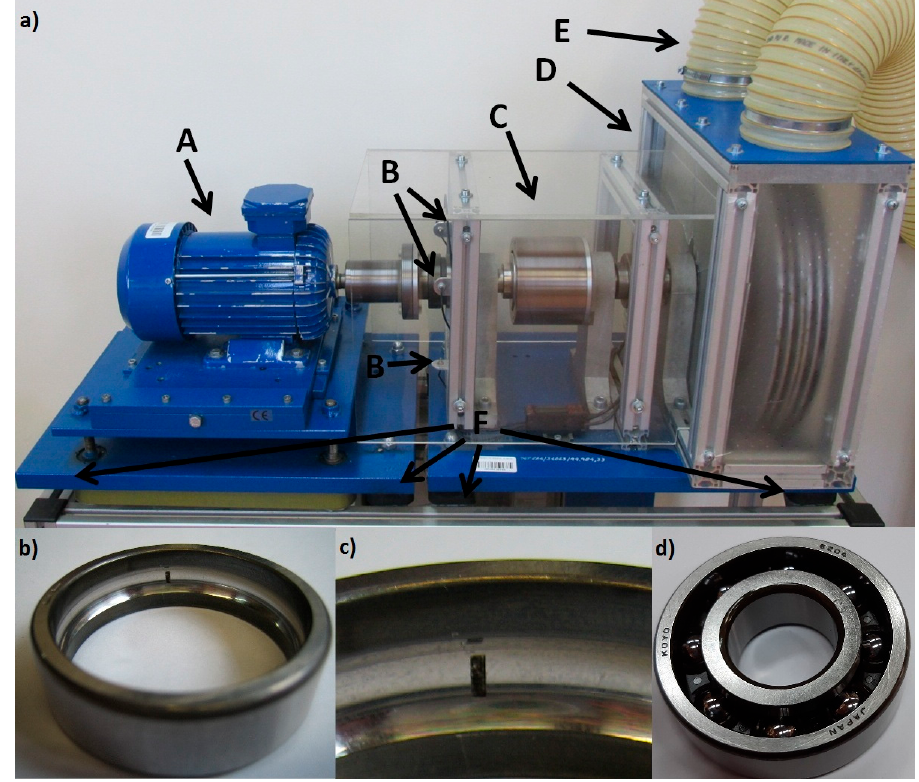
Figure 4. ( a ) The experimental test rig, ( b ) The damaged outer ring of the faulty bearing, ( c ) a closer look into the outer ring damage, and ( d ) The pristine bearing.